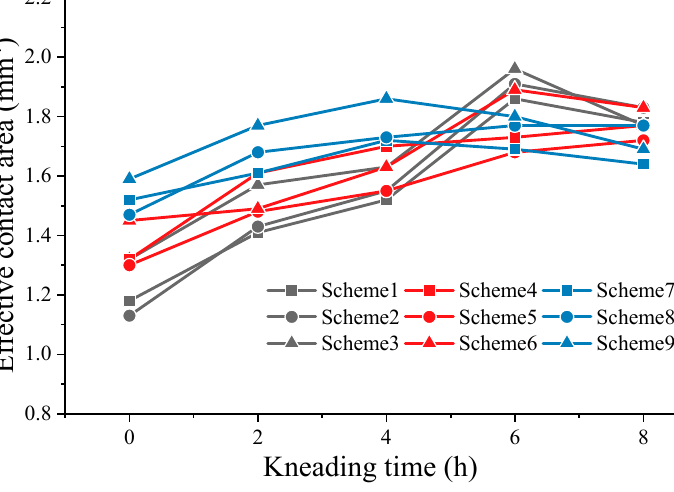
Figure 10. Results for effective contact area.